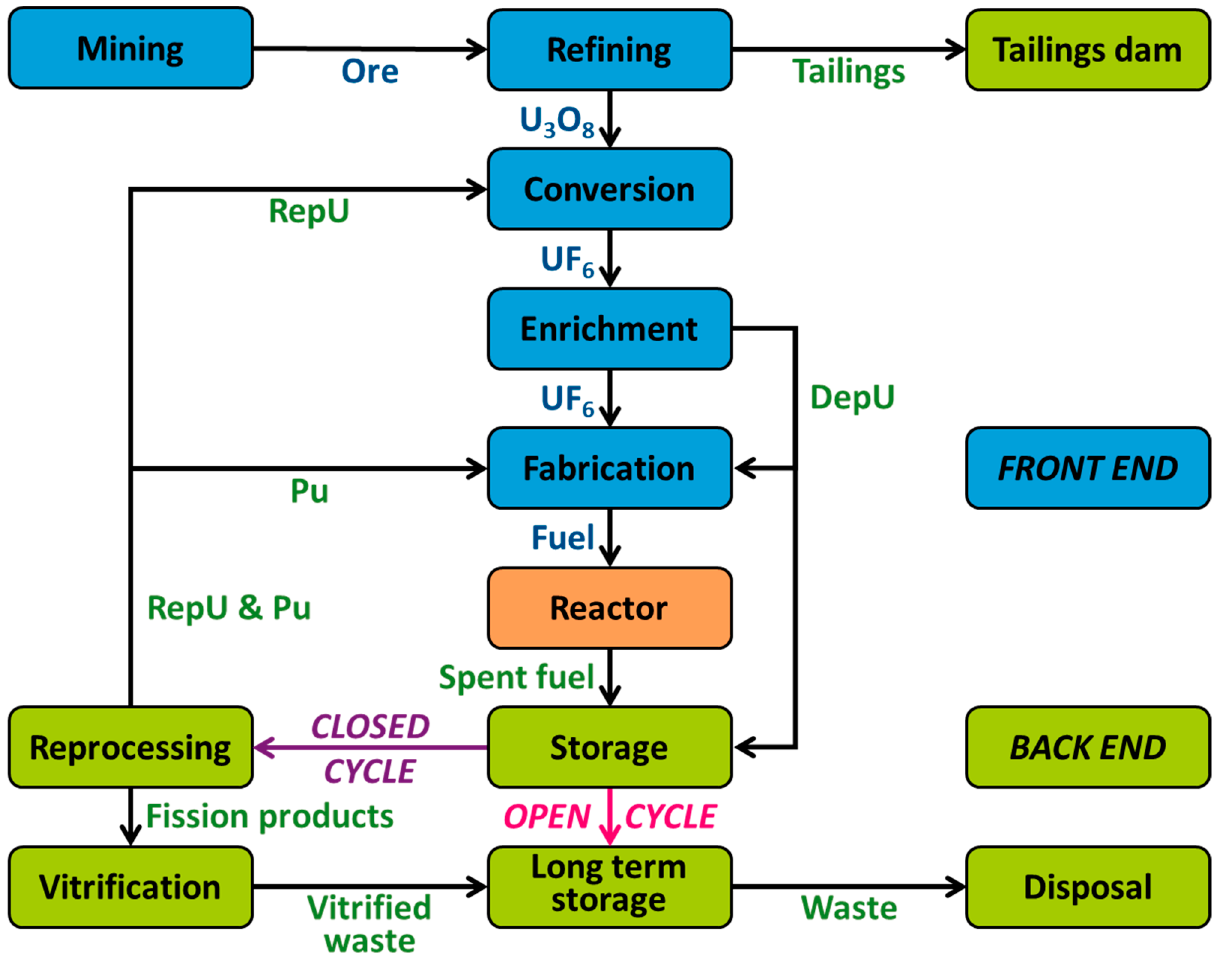
Figure 1. The nuclear fuel cycle.